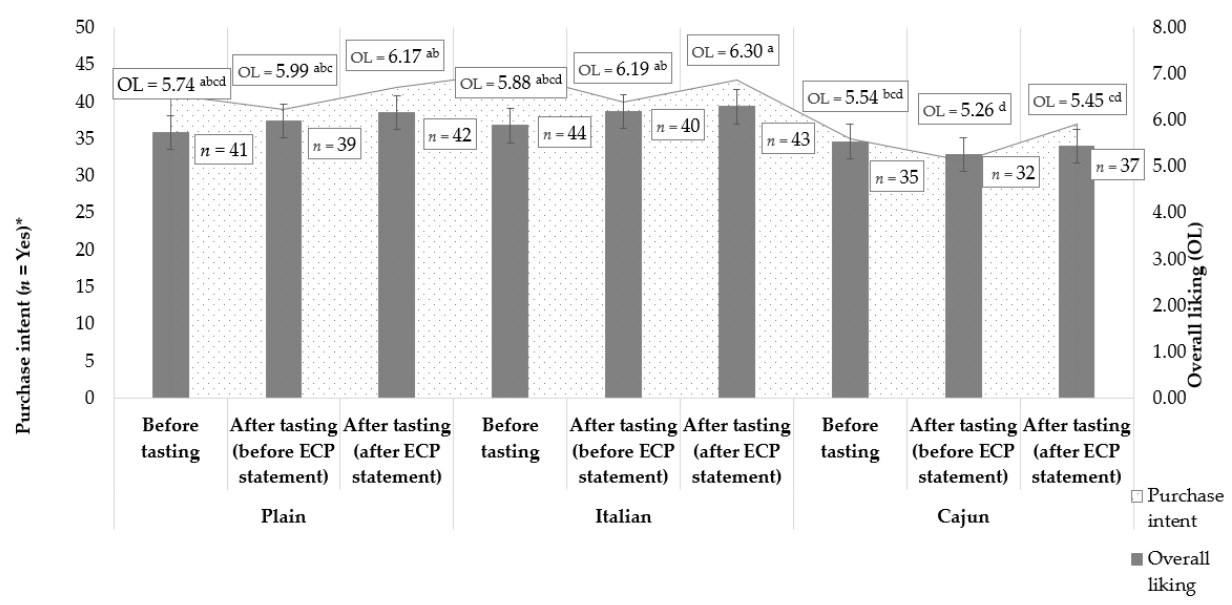
Figure 3. Treatments overall liking (OL; grey bars) and purchase intent (PI; trend line) chart comparing formulations and moments (before tasting, after tasting, and after edible cricket protein (ECP) statement). Data are OL least square means and standard errors/frequencies of PI = Yes from n = 84 consumers. Treatments are described in Figure 1. Different lowercase letters indicate significantly (p < 0.05) different OL scores (Tukey’s means separation) across treatments and moments. * No significant (p > 0.05) difference in PI frequencies across treatments with in a given moment or across moments within a given treatment (Cochran’s Q test followed by asymptotic McNemar test for post hoc multiple pairwise comparisons and p-value adjustment by false discovery rate).